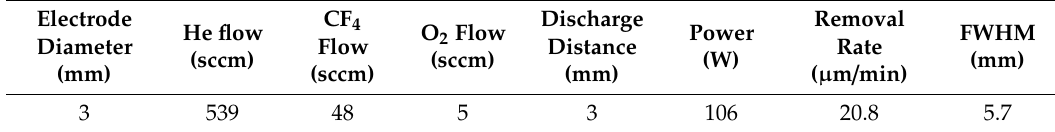
Table 5. Process parameters for removal function 1 (cid:79) .